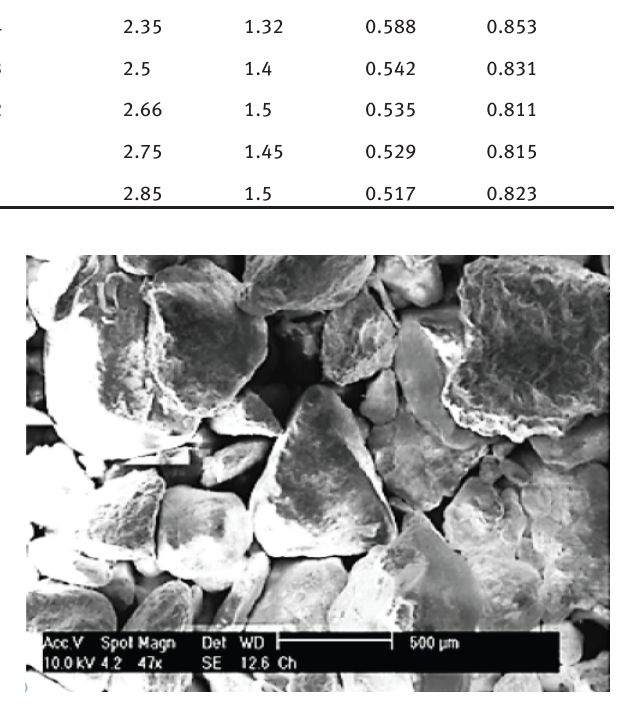
Figure 1: Scanning electron microscope view (SEM) of Chlef sand, Della et al. (2014).